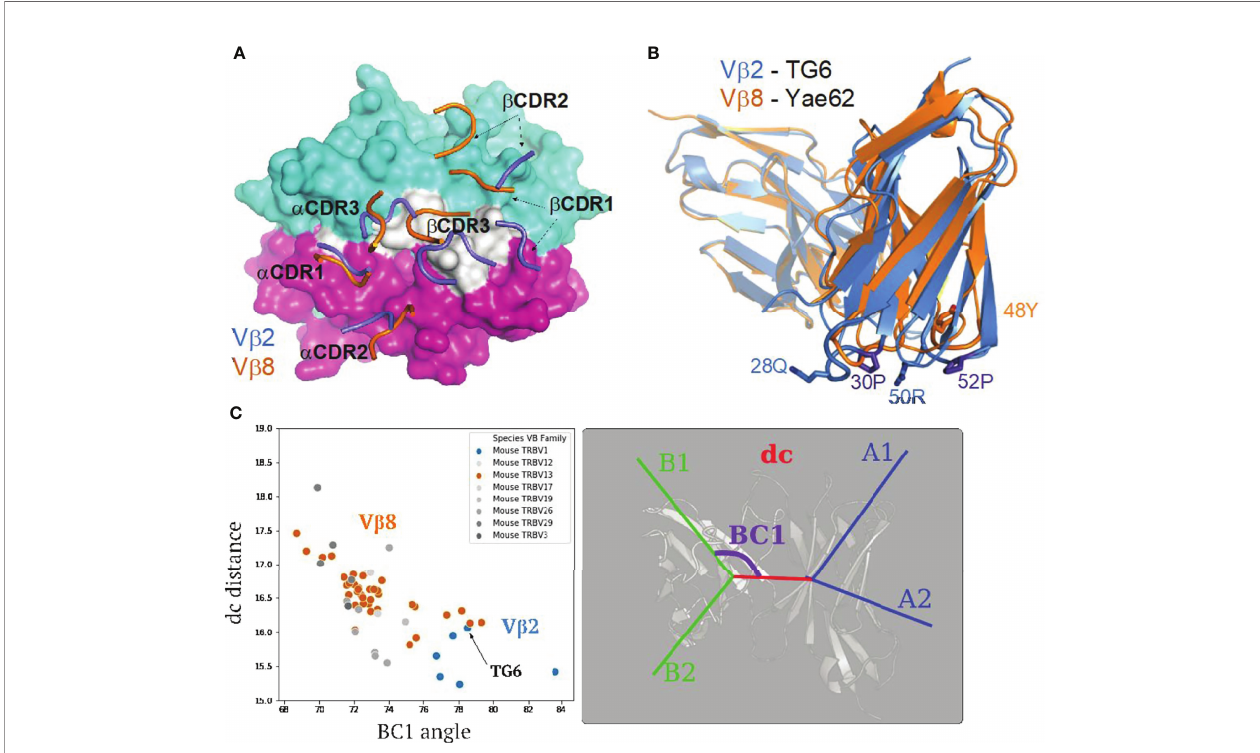
FIGURE 4 | Structural differences between V b 2 and V b 8 containing TCRs lead to an altered footprint for pMHC binding. (A) A comparison of the positions of CDR loops from TG6 and YAe62 TCRs over their pMHC ligands. CDR loops from TG6 are shown in blue and Yae62 are in orange. (B) Ribbon diagrams of TG6 TCR (V b 2) and YAe62 TCR (V b 8) overlaid with their TCR a chains aligned (both V a 4 encoded by TRAV6). Note that there is a shift in the juxtaposition of TCR a and TCR b domains that contributes to the shift in the position in the CDR loops of TCR a relative to TCR b . In addition, proline residues in the CDR1 and CDR2 loops of V b 2 lead to a further shift in the CDR1 and 2 loops away from the a 1 helix of MHC and toward the peptide and a 2 helix of MHC-I (or b 1 helix of MHC-II) See Movie S3. (C) TRangle parameters dc distance and BC1 angle for the TG6 TCR (indicated by arrow) compared to non-redundant TCR structures in the PDB. V b 2 TCRs are shown in blue and V b 8 TCRs are in orange. Right panel shows TRangle parameters used to de fi ne the V a V b interface geometry superimposed over a ribbon diagram of